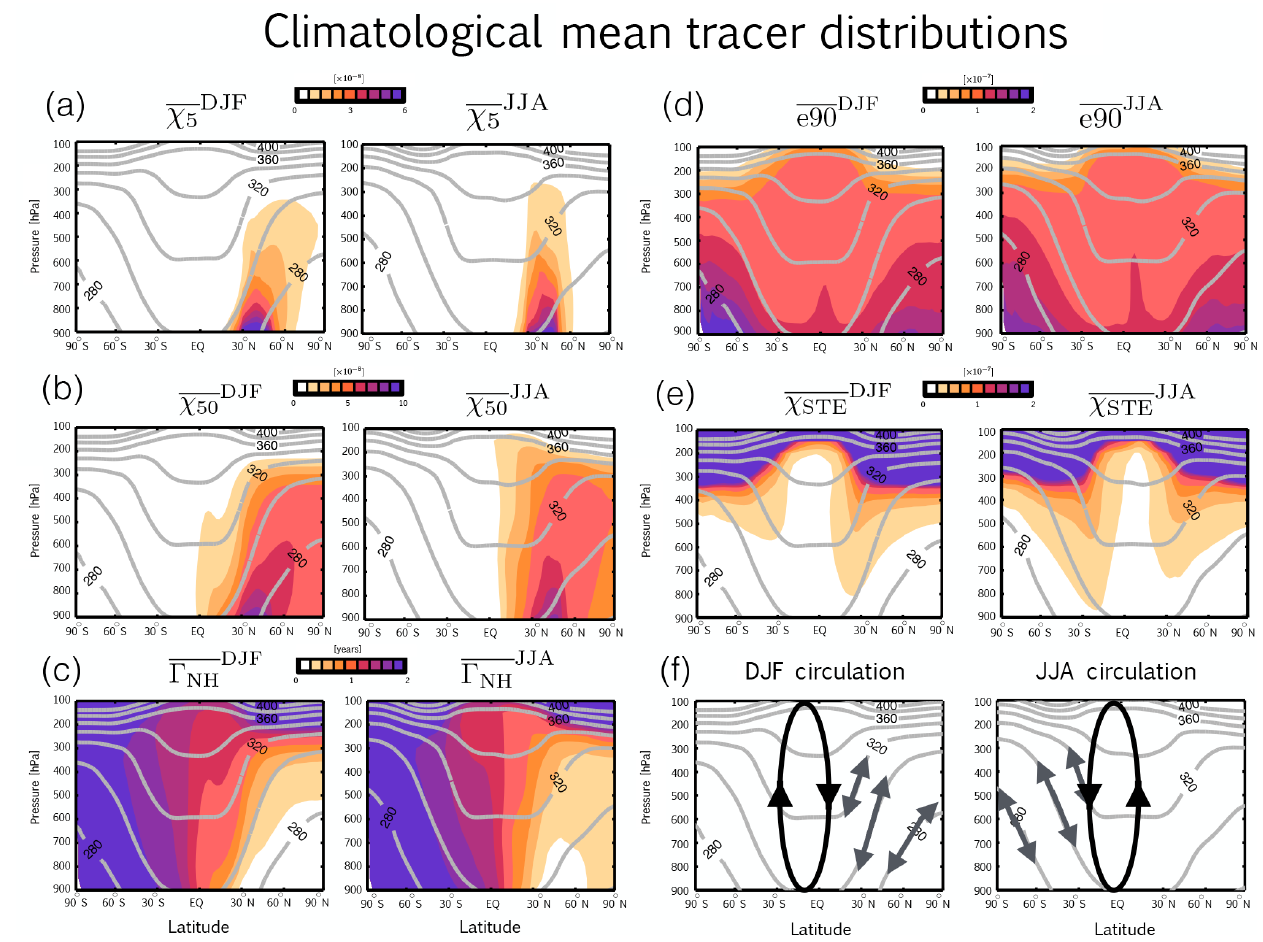
Figure 1. Climatological mean December–January–February (DJF) (a–c) and June–July–August (JJA) (d–f) zonally averaged distributions of the 5-day idealized loss tracer χ 5 (a) , the 50-day idealized loss tracer χ 50 (b) , the mean age since air was last at the NH midlatitude surface (cid:48) NH (c) , the stratospheric global source tracer χ STE (d) and the global surface source tracer e90 (e) . Schematic representations of the seasonally averaged mean meridional circulation, overlaid with arrows denoting eddy mixing, are shown in panel (f) . 2000–2009 climatological means are shown for the NASA Global Modeling Initiative (GMI) Chemical Transport Model (CTM), which is constrained with MERRA meteorological fields and denoted in all remaining figures as the GEOS-CTM simulation. Climatological seasonal mean dry potential temperature is shown in the grey